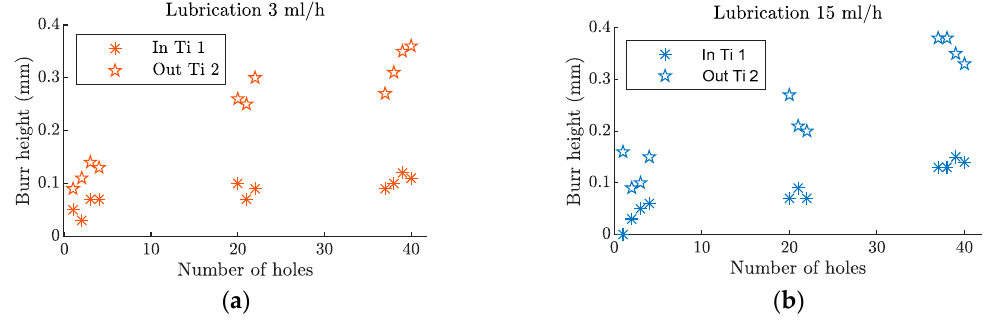
Figure 8. Burr height evolution, after 40 holes, in a hybrid Ti/CFRP/Ti stack with a ( a ) lubrication level of 3 mL/h and a ( b ) lubrication level of 15 mL/h.